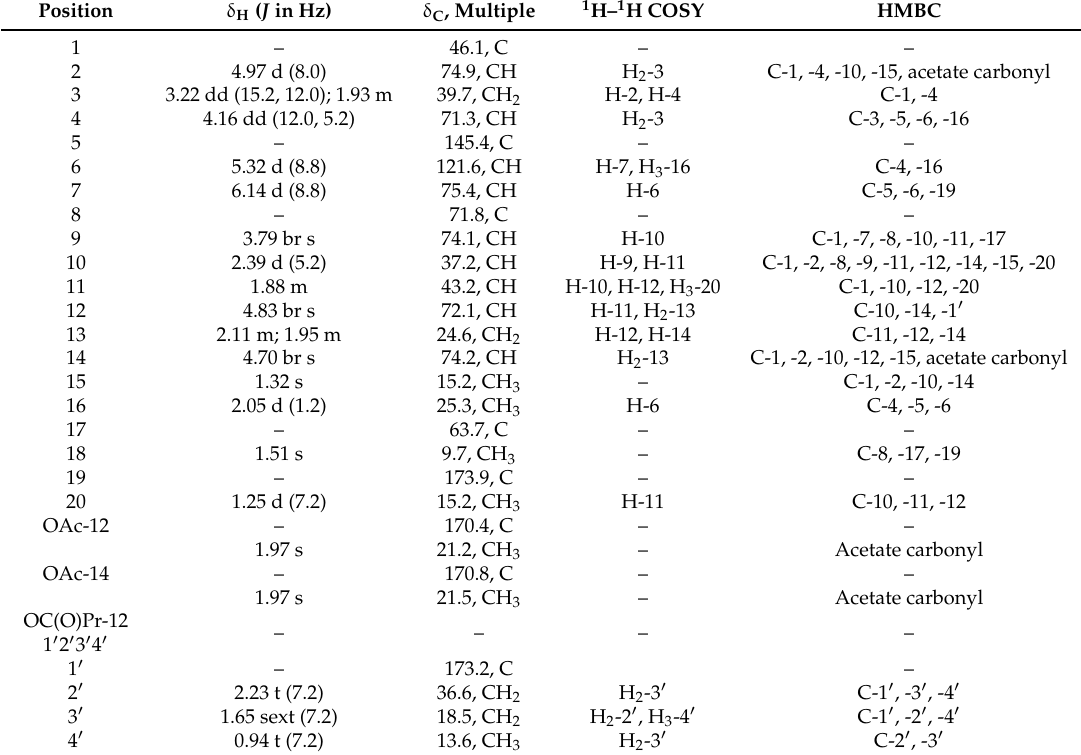
Table 4. 1 H (400 MHz, CDCl 3 ) and 13 C (100 MHz, CDCl 3 ) NMR data and 1 H– 1 H COSY and HMBC correlations for briarane 4